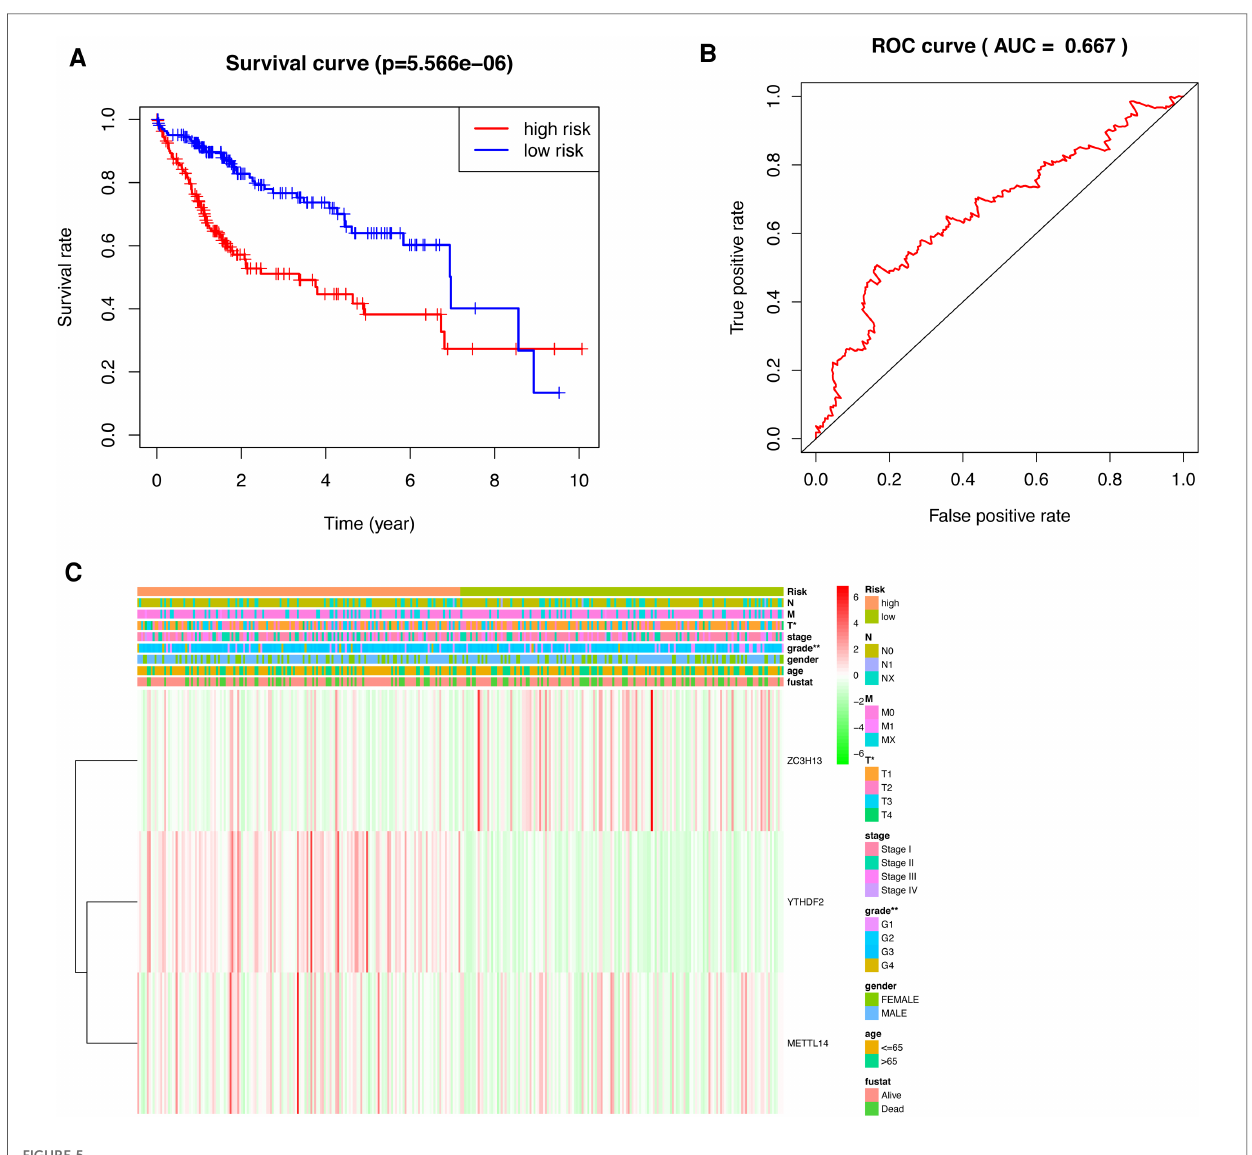
FIGURE 5 Prognostic model of HCC patients. ( A ) The survival curves for the low-risk and high-risk groups ( B ) ROC curve of OS-related prognostic model in TCGA cohort. ( C ) A risk-clinical correlation heatmap.